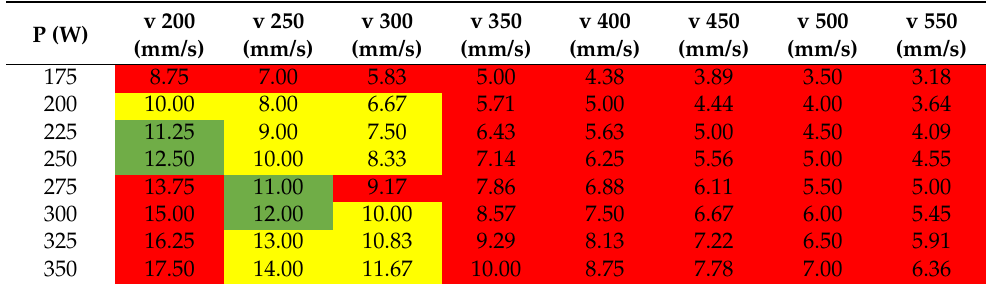
Table 8. Evaluation of single tracks based on visual inspection (red—unsuitable, yellow—partially suitable,